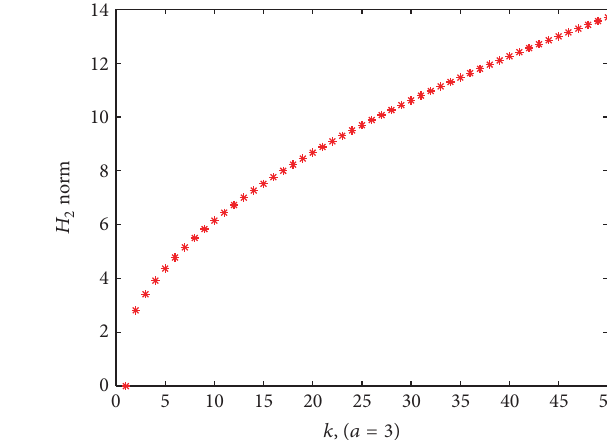
Figure 8: The variance of 𝜆 2 for 𝐾 𝑎,𝑎 ∘ 𝑃 3 .